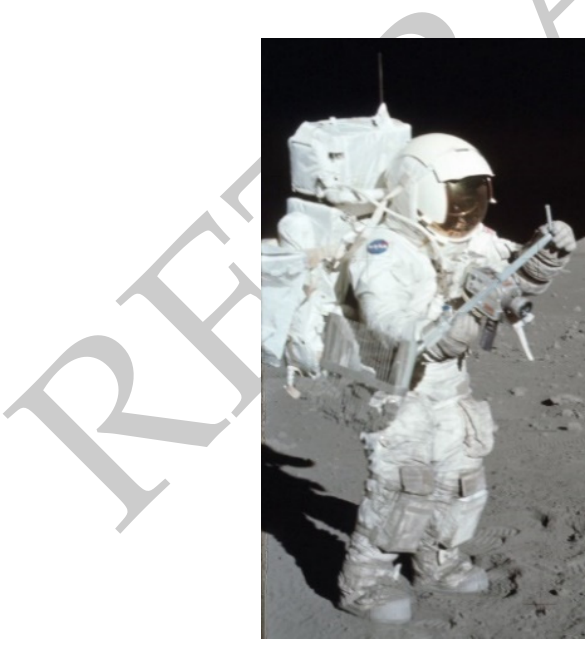
Figure 8. Project Apollo Archive photo (part) AS17-134-20426 [30], showing Apollo 17 astronaut with camera held in the chest fixture.